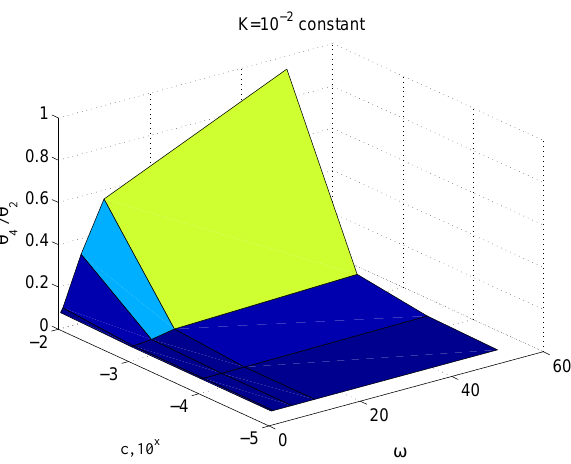
Figure 15. Dependency of ϑ 4 / ϑ 2 with respect to c and ω for an assigned value of k .